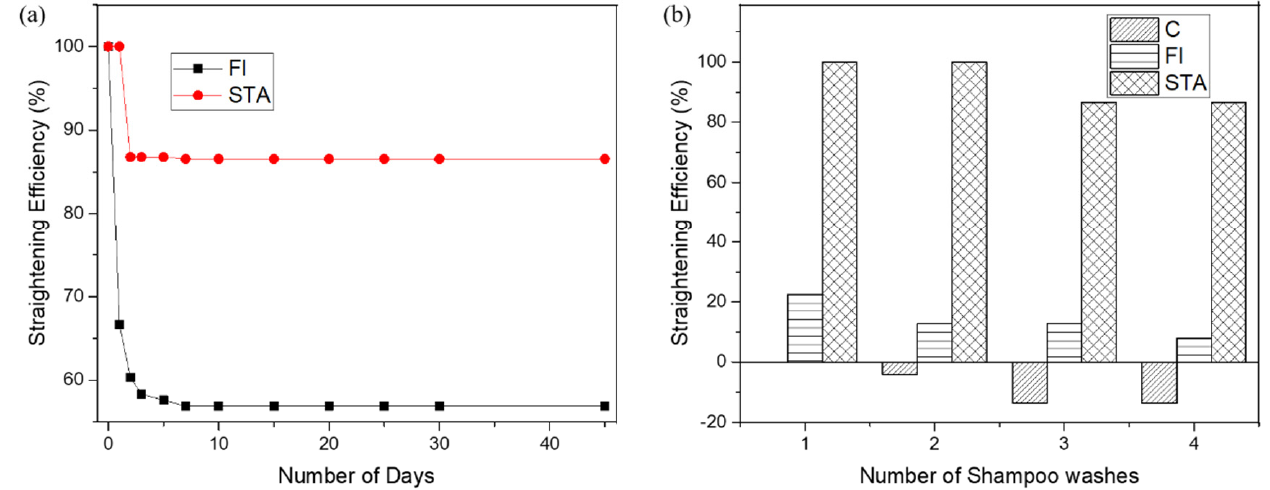
Figure 4. Straightening efficiency (SE) of FI and STA hair (hung vertically) at 21 °C and 65% RH as a function of ( a ) the number of days and ( b ) the number of shampoo washes.